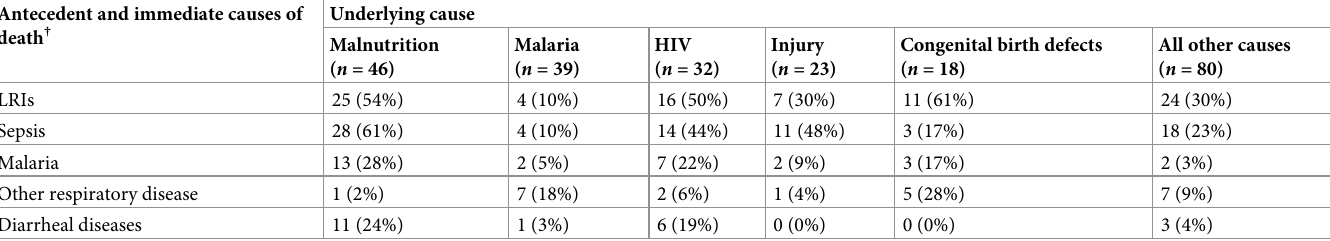
Table 10. Most common additional conditions (antecedent and immediate CoD) in the causal chain for the 5 leading underlying causes of child deaths in CHAMPS. � Antecedent and immediate causes of death